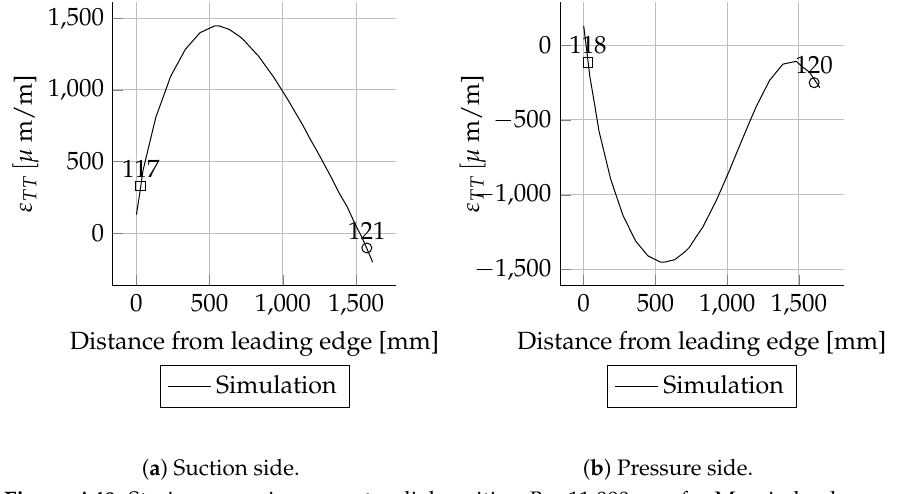
Figure A48. Strain comparison ε LL at radial position R = 11,000 mm for Mymin load case.